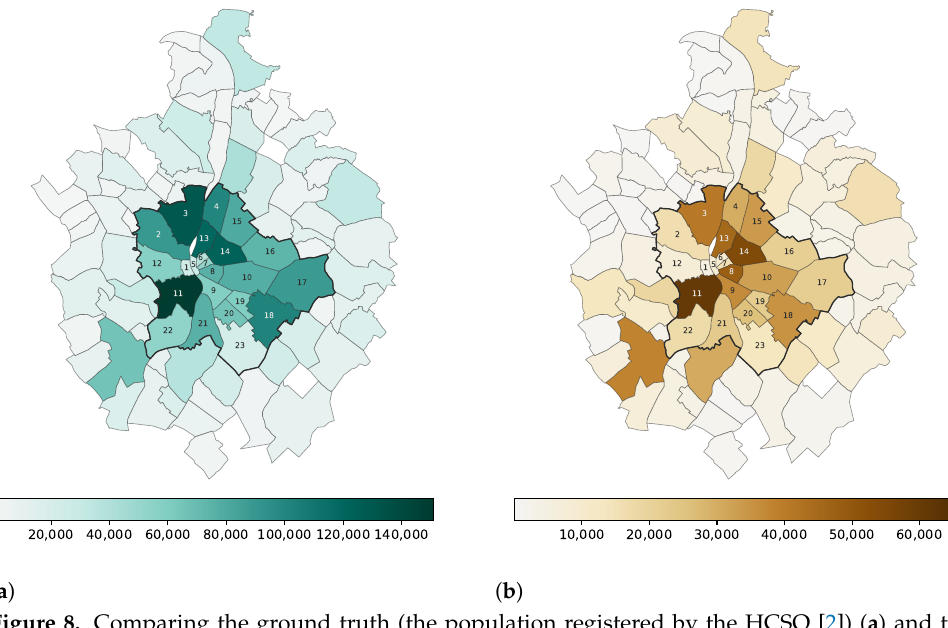
Figure 8. Comparing the ground truth (the population registered by the HCSO [2]) ( a ) and the detected population based on mobile network data ( b ). The district numbers of Budapest are also